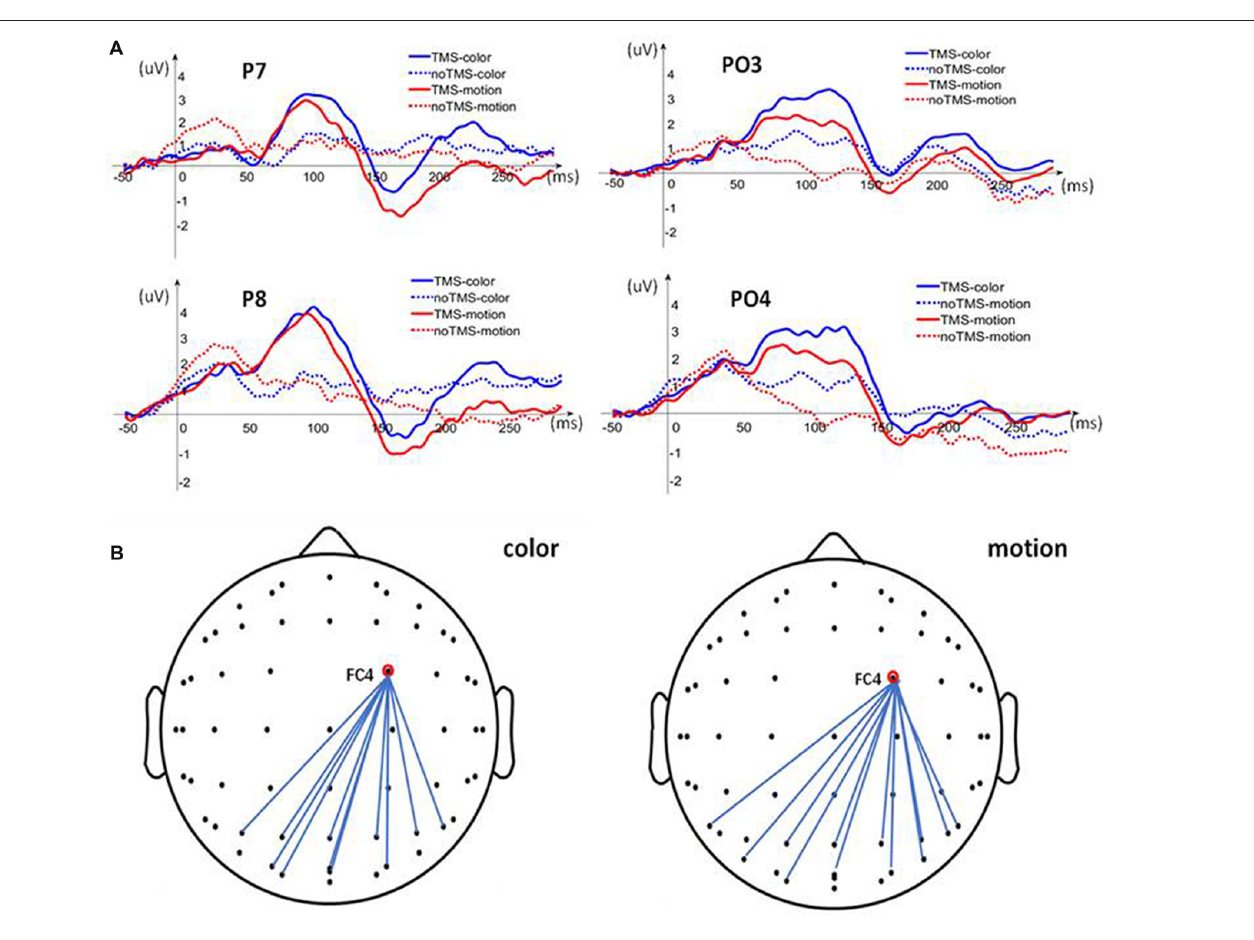
FIGURE 3 | Analysis of signal amplitudes. (A) Posterior electrode (P7, P8, PO3 and PO4) signal amplitude compared between the TMS-event-related potential (ERP) and no TMS-ERP trials for both color and motion. (B) Pearson correlation analysis between FC4 (corresponding to the rFEF) and electrodes in the parietal and posterior brain